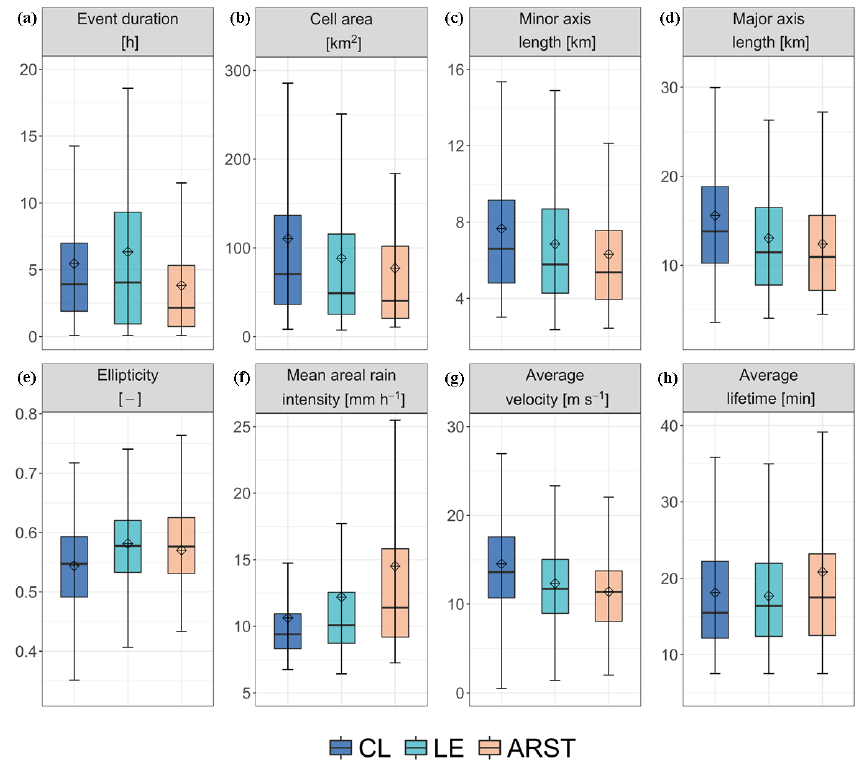
Figure 5. Comparison of rain-cell properties (averaged for each rain event) of the three synoptic systems: CL (dark blue), LE (light blue) and ARST (orange); (a) average event duration (h), (b) cell area (km 2 ), (c) minor axis length (km), (d) major axis length (km), (e) ellipticity (–), (f) mean areal rain intensity (mmh − 1 ), (g) average velocity (m s − 1 ), and (h) average lifetime (min). The black line in each boxplot marks the median, black diamond the mean, boxes lower and upper borders mark the 25 and 75% quartiles, respectively, and the whiskers mark minimum and maximum values unless these values exceed 1.5 · IQR (inter quartile range – the distance between lower and upper quartiles). Outliers are not shown. See Table 2 for numerical values of the mean and standard